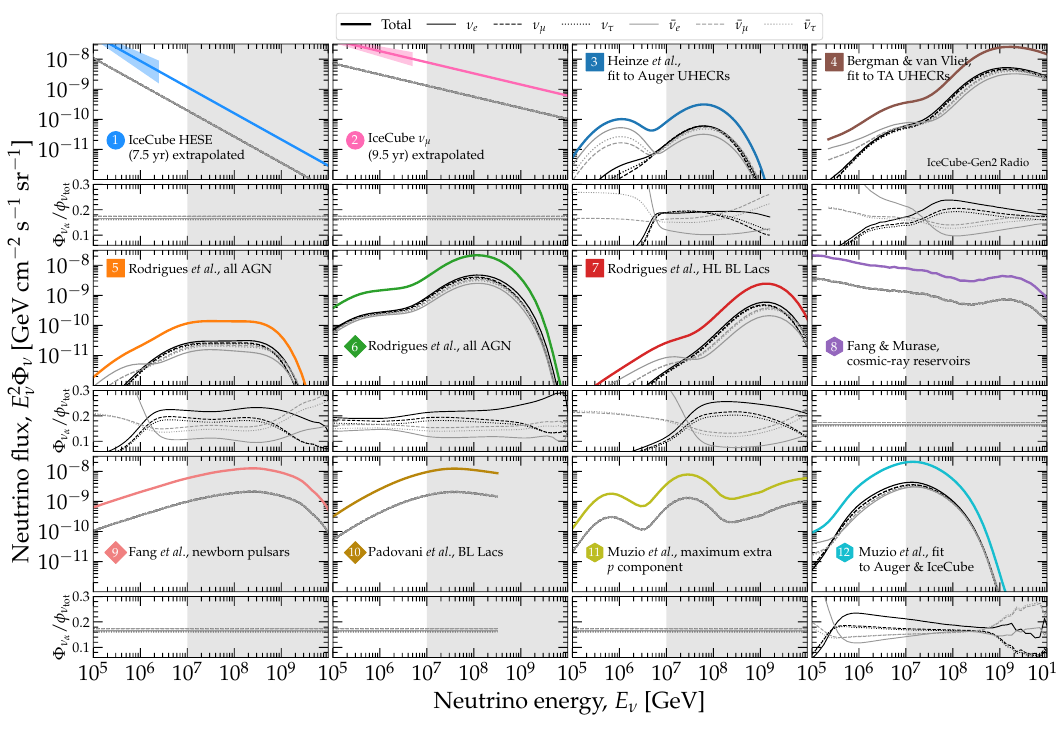
Figure 6 . Flux of each neutrino species for each of the benchmark ultra-high-energy neutrino fluxes that we consider (see figure 5). Panels under the fluxes show the ratio Φ to the total flux, i.e., the sum of the fluxes of all species. For flux models 1, 2, and 7, the ratios are constant in neutrino energy and approximately equal to 1/6; the exact values are in section 4.2. For all the other flux models, the ratios change with neutrino energy. See the main text for details. The shaded region indicates the approximate neutrino energy range to which the radio array of IceCube-Gen2 will be